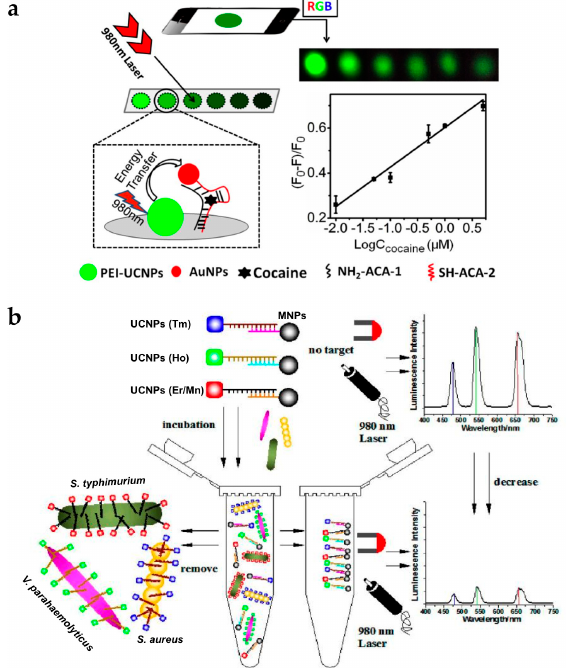
Figure 6. ( a ) Schematic of the UCNP-based paper assay for cocaine testing; ( b ) Schematic illustration of multiplexed luminescence assay for simultaneous detection of various bacteria. Reprinted with permission from [62,63].